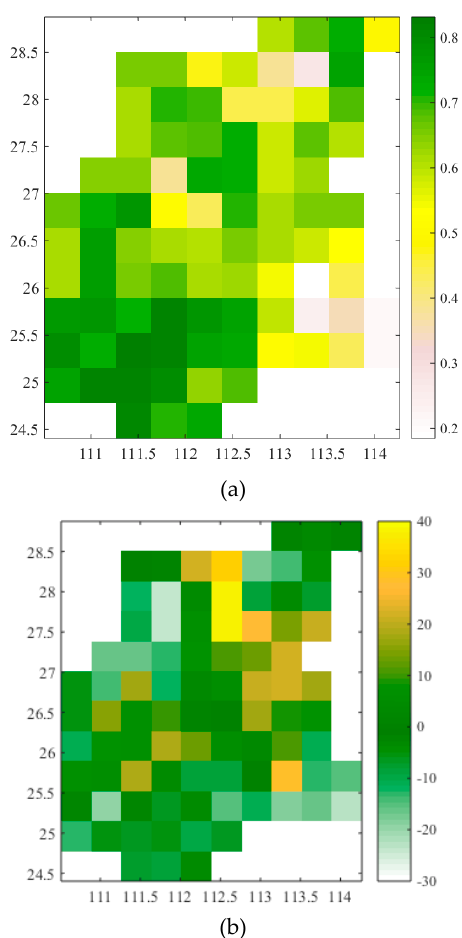
Figure 2. R-values ( a ) and BIAS ( b ) values between Soil Moisture Active Passive (SMAP) soil moisture and China Land Soil Moisture Data Assimilation System (CLSMDAS) soil moisture datasets.